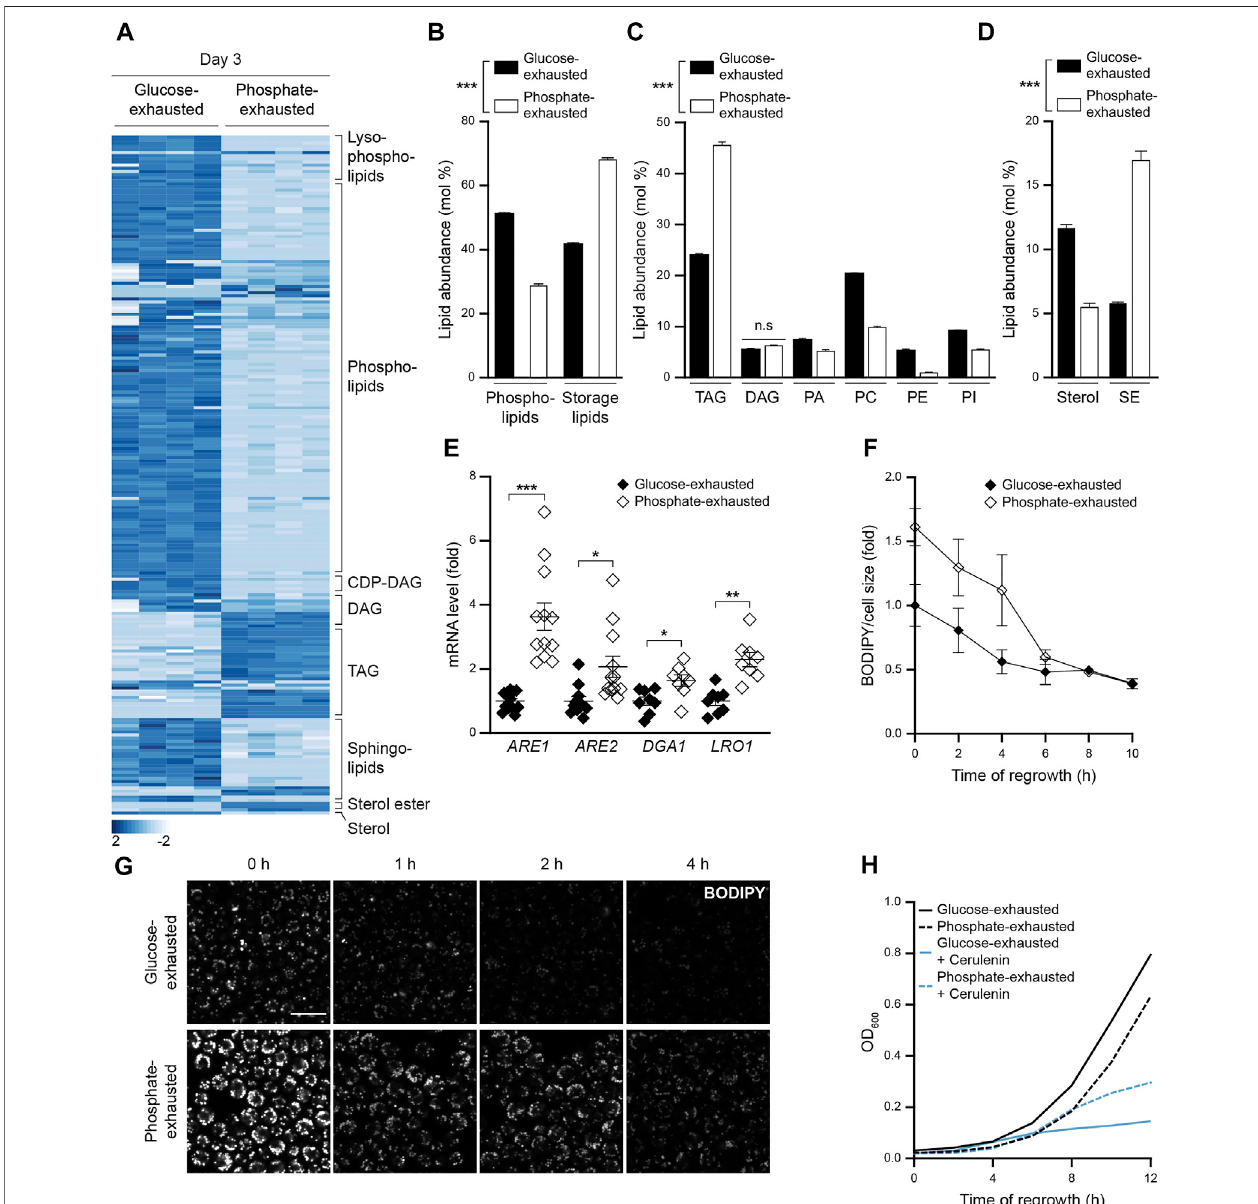
FIGURE 2 | Phosphate exhaustion boosts the synthesis and availability of neutral lipids to support regrowth when nutrients are replenished (A) Heatmap of all signi fi cantly altered lipid species comparing total cellular lipid extracts of WT (BY4741) cells subjected to glucose or phosphate exhaustion for 3 days; n = 4 (B-D) Lipidomic quanti fi cation of total phospholipids and storage lipids (B), high abundant lipid classes (TAG triacylglycerol; DAG diacylglycerol; PA phosphatidic acid; PC phosphatidylcholine; PE phosphatidylethanolamine; PI phosphatidylinositol) (C) and sterols and sterol esters (SE) in lipid extracts of cells described in (A), depicted asmol%ofsample.Mean±SEM;n=4.Correspondinglevelsoflowabundantlipidclassesareshownin SupplementaryFigureS2(E) qRT-PCR-basedquanti fi cation ofmRNAlevelsof ARE1,ARE2,DGA1 and LRO1 inWT (BY4742)cellsatday 1ofglucose orphosphate exhaustion.ComparativeCTmethod ( ΔΔ CTmethod) wasused to calculate the relative gene expression using TAF10 as housekeeping gene, and values are depicted as fold of glucose-exhausted cells; n = 8 – 12 (F) Flow cytometric quanti fi cation of LD consumption upon nutrient replenishment after prolonged glucose or phosphate exhaustion. After 3 days of nutrient exhaustion, cells were re- inoculated in unrestricted, fresh standard medium and LD content was quanti fi ed using BODIPY at indicated time points. Values were normalized to respective cell size anddataisshownasfoldofglucose-exhaustedcellsat0 h,correspondingto3 daysofnutrientexhaustion.Mean±SEM;n=8 (G) ConfocalmicrographstovisualizeLD consumption during regrowth. After 3 days of nutrient exhaustion, cells were stained with BODIPY and immobilized on agar slides with unrestricted, fresh standard medium and were visualized at indicated time points. Scale bar: 5 μ m (H) Regrowth of cells after prolonged glucose or phosphate exhaustion. After 3 days of nutrient exhaustion,cellswerere-inoculatedinunrestricted,freshstandardmediumandOD 600 wasmonitoredevery2 h.Whereindicated,cellsweretreatedwith1 µMcerulenin at the time point of re-inoculation to inhibit fatty acids biosynthesis; n = 4. For more details in respect to statistical analyses, please see Supplementary Table S4 .